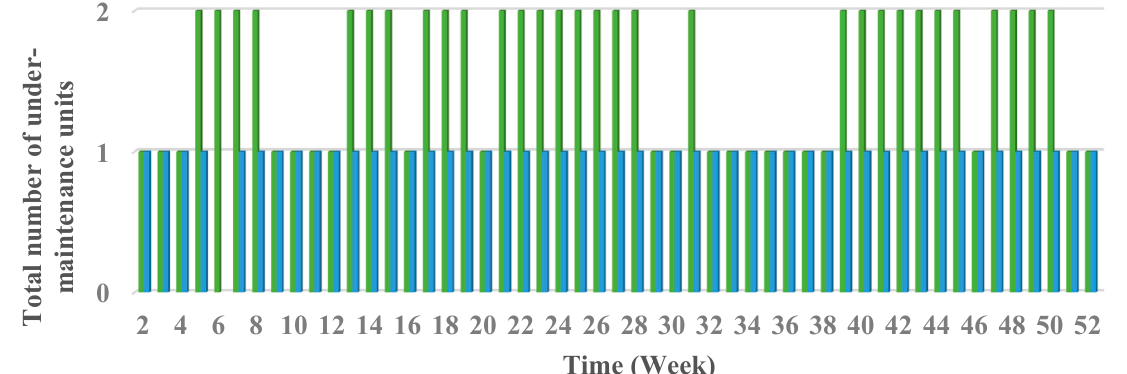
Figure 18. Total number of under-maintenance power-producing and heat-producing units respect to week.